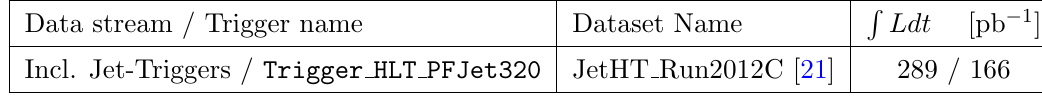
Table 1 . Overview of data samples used in this analysis together with the corresponding integrated luminosity and the triggers, which have been used during the data